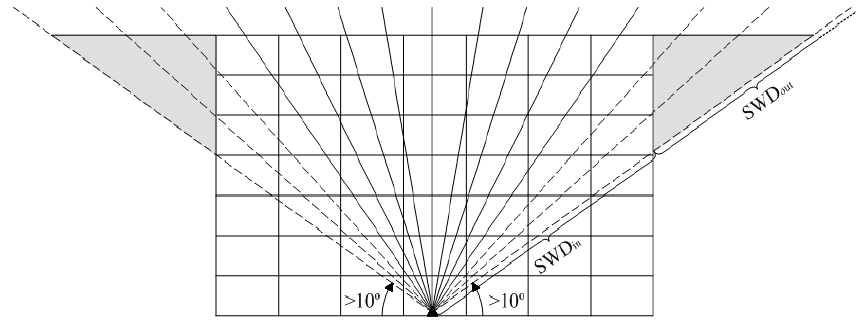
Figure 2. Schematic diagram of rays used in the tomography. The rectangle defines the tomographic region. Normally, only rays (in solid lines) that enter the tomographic model from the top layer can be used, and rays (in dashed lines) entering from the laterals should be